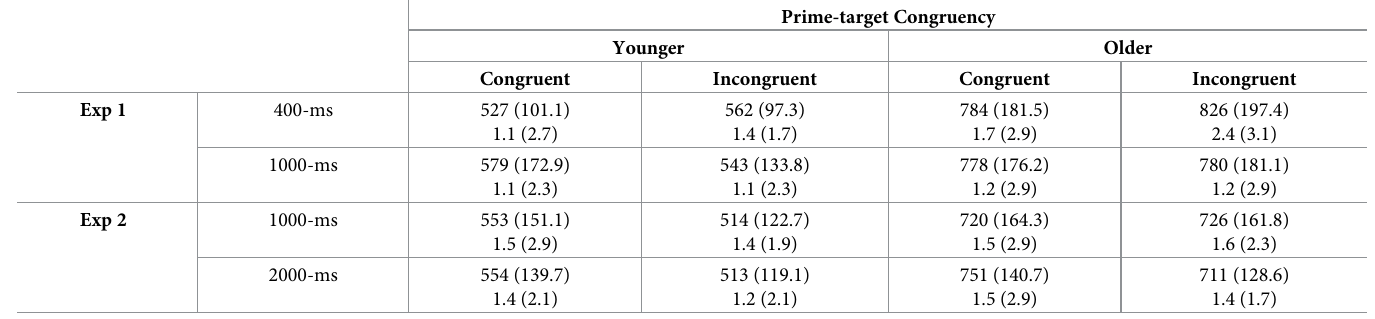
Table 3. Responses in the Stroop-Priming task for Experiments 1 and